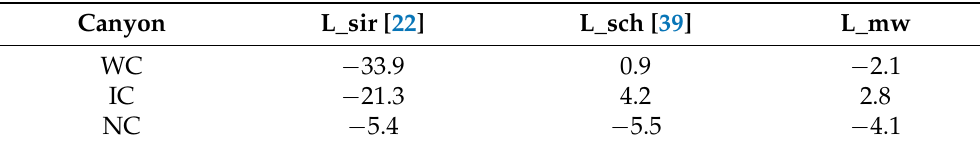
Figure 2. Comparison of the normalized vertical transfer coefficient ( q vert / ( u ∗ H ) ) between Code_Saturne (CS), Soulhac et al. [22] (L_sir), Schulte et al. [39] (L_sch) and modified Wang [37] (L_mw) depending on a r . Table 3. The q vert relative deviation (%) between Code_Saturne and MUNICH parametrizations for the three canyon